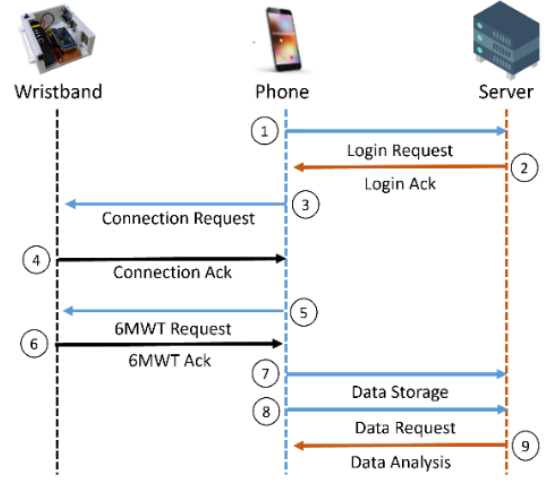
Figure 1. Communication protocol.